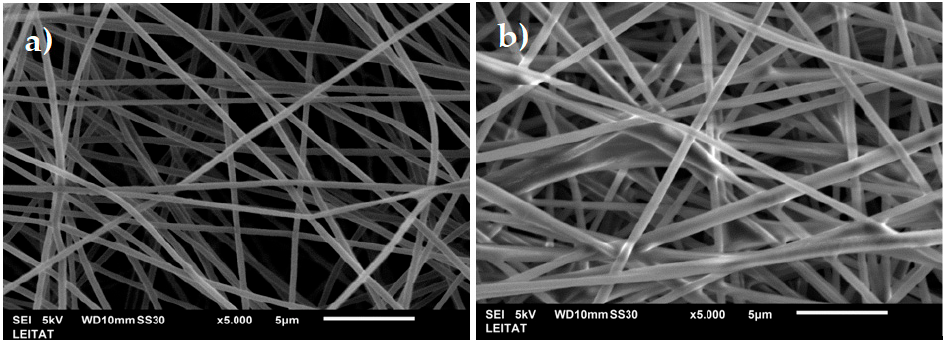
Figure 2. SEM images of ( a ) PAN unmodified and ( b ) PAN-272 nanofibers.